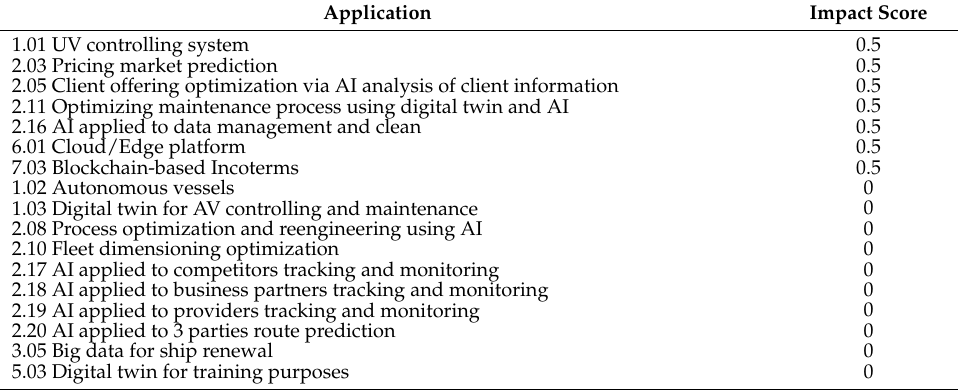
Table 9. Bottom applications on Cost performance dimension.